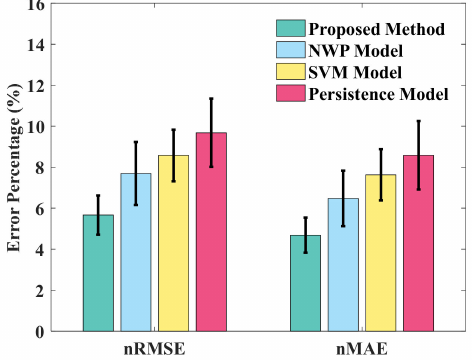
Figure 16. Error comparison of each regional forecast